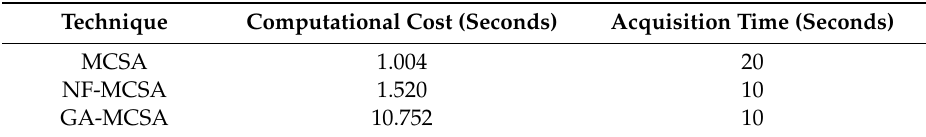
Table 3. Computational cost and acquisition time